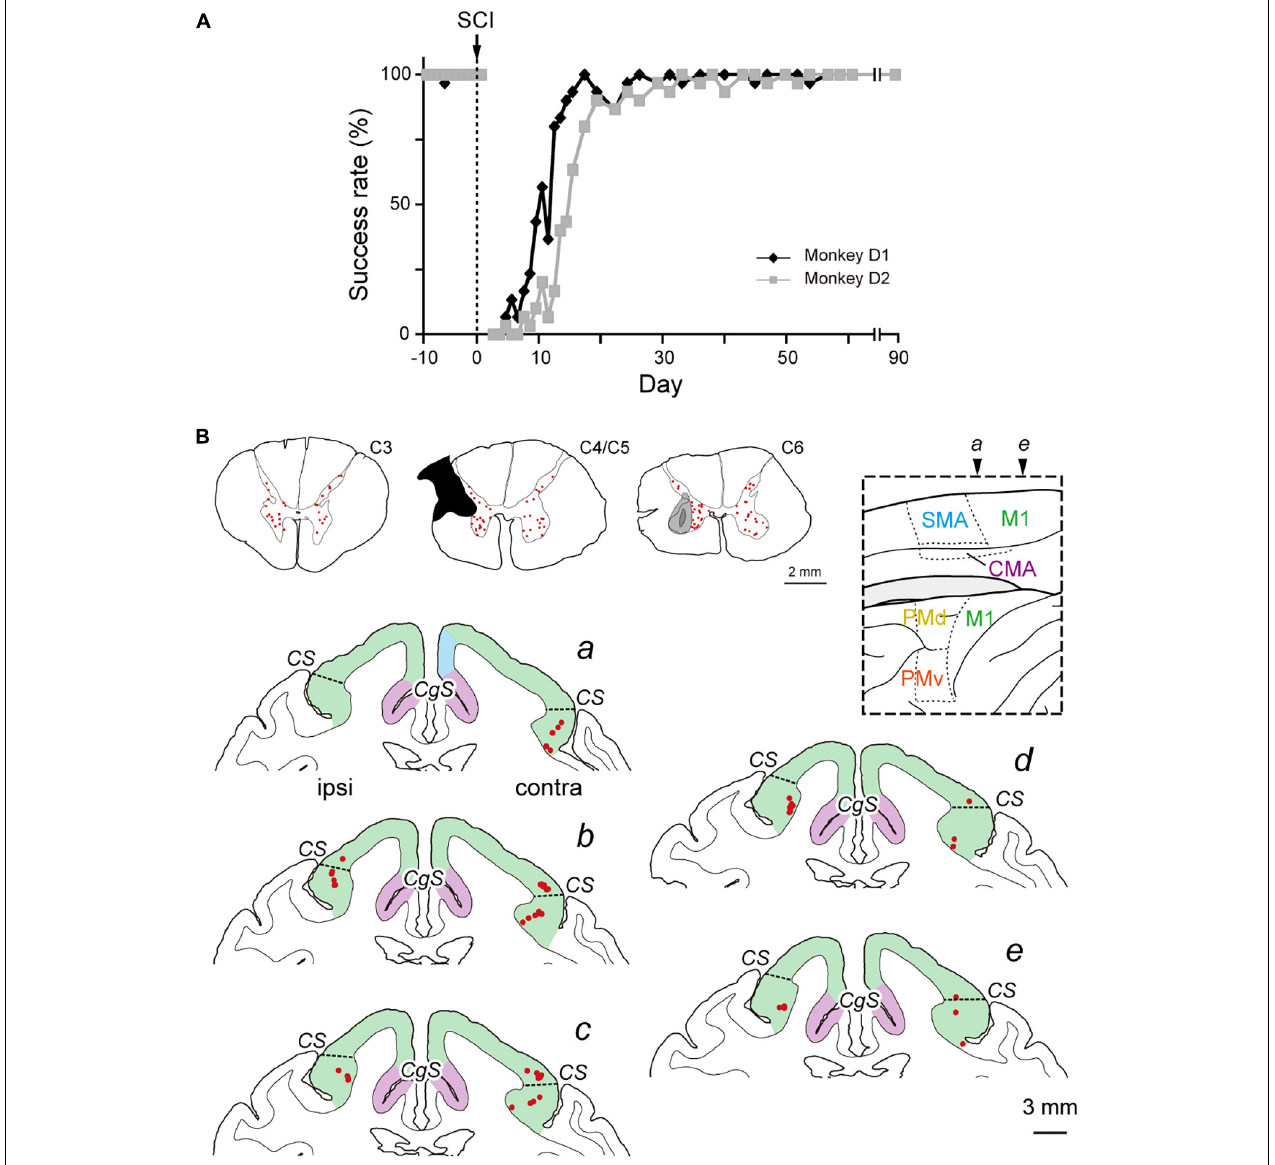
FIGURE 3 | Distribution of diCSP neurons at recovery period after SCI (monoCSP lesion) (Experiment D). (A) Time-course of the performance of the motor (precision grip) task for two monkeys (monkeys D1 and D2). Any trial was judged as a success trial in which the monkeys successfully removed food from a slot and brought it to the mouth within 10 s. Each data point was derived from 42 trials in total (3 trials × 7 times for vertical and horizontal slots, respectively; see Materials and Methods for details). The task performance was largely impaired immediately after SCI, and the success rate recovered almost fully within 3 weeks. The behavioral test was continued 3 months until the recovery of manual dexterity was confirmed, and then, the monkeys received rabies injections into the spinal forelimb segments (C6–T1). (B) Distribution of diCSP neurons in the frontal motor-related areas 3 days after the rabies injections in monkey D1 ( a –e). Representative transverse sections showing retrograde labeling in the upper cervical segments, the maximum extent of SCI, and the site of rabies injection are depicted in sections C3, C4/C5, and C6, respectively. In section C4/C5, glial scar (blackened area) is seen due to the 3-month survival period after SCI. Again, numbers of neurons are labeled bilaterally in the upper cervical segments, including the propriospinal neurons. In the sections b – e , the second-order neuron labeling is located not only in the contralateral, but also in the ipsilateral M1. By contrast, each of the other motor-related areas contains only a few labeled neurons. Note that virtually no labeled neurons are detected in the cortical areas anterior to section a . Other conventions are as in Figures 1 , 2